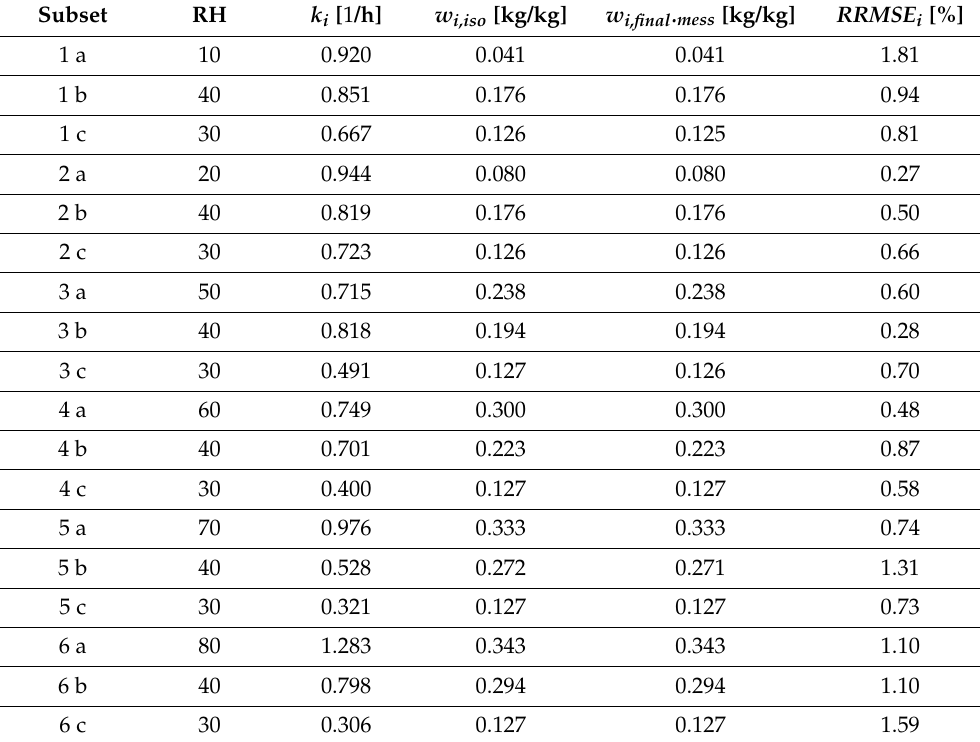
Table 1. Fitted model parameter k i and w i , iso for the 18 subsets; measured parameter w i , final , mess and the RRMSE of each